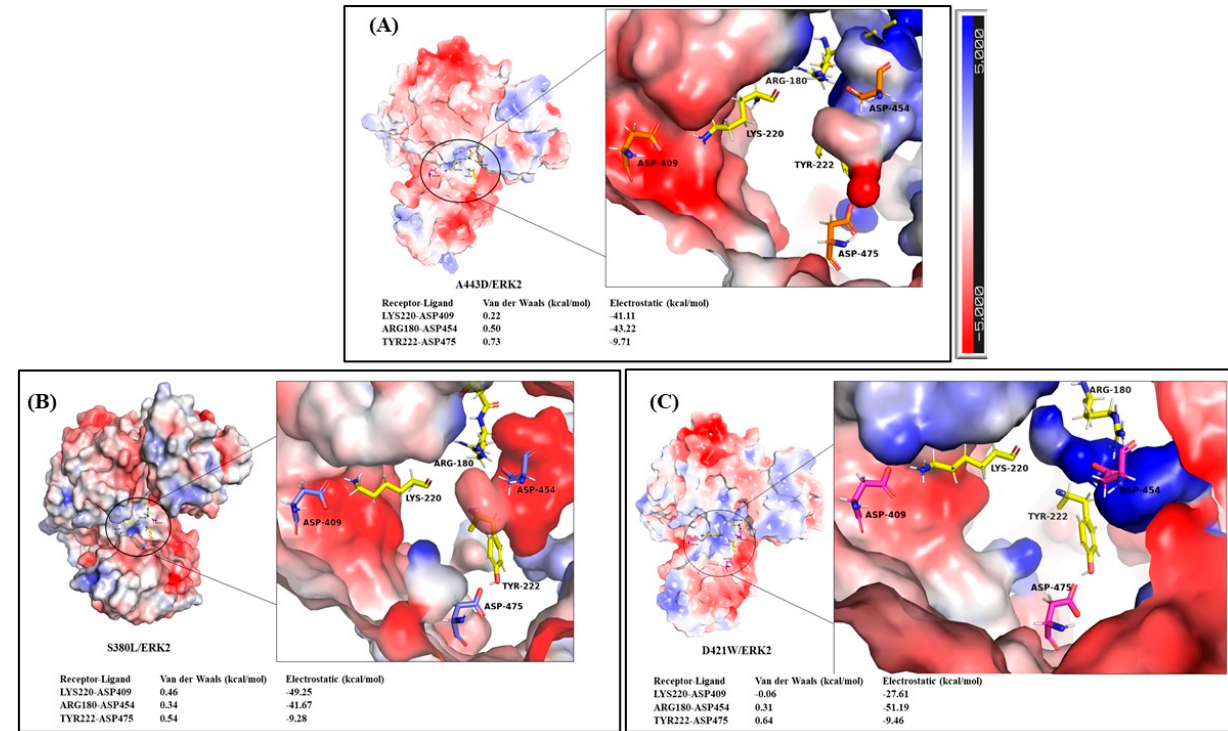
Figure 7. Electrostatic potential surface of interacting residues (enlarged) in ( A ) A443D/ERK2 ( B ) S380L/ERK2, and ( C ) D421W/ERK2. Highly electronegative regions shown by red while electropositive regions are shown by blue color. Respective van der Waals and electrostatic energies for the receptor-ligand pairs are shown in bottom left corner. Red indicates highly electronegative, while blue shows electropositive residue surfaces (see bar). The areas of high electrostatic potential are found near the interface of DARPin and ERK2 in all the structures.